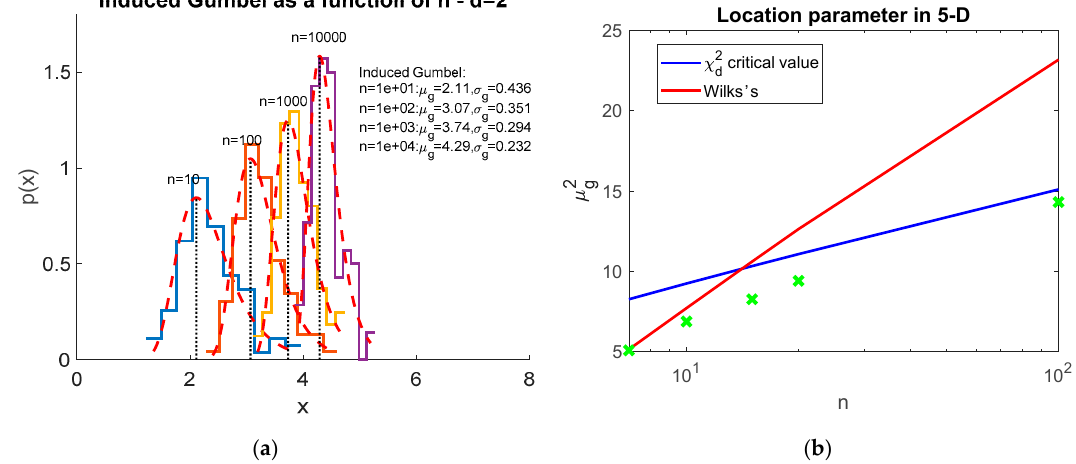
Figure 11. ( a ) Several different Induced Gumbel distributions for the maxima arising from a bivariate standard normal, as a function of n , for m = 100 Monte Carlo Repetitions. ( b ) Monte Carlo sampling from a 5-dimensional multivariate normal with random mean and covariance matrix. The ˆ µ 2 g values obtained from fitting a Gumbel (green dots) are compared to the theoretical µ 2 g ( n ) critical values form χ 2 and Wilk’s criteria.